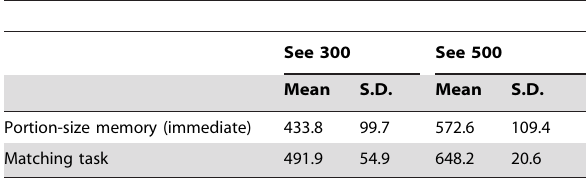
Table 2. Portion size estimates (ml) from participants who saw 300 ml or 500 ml of